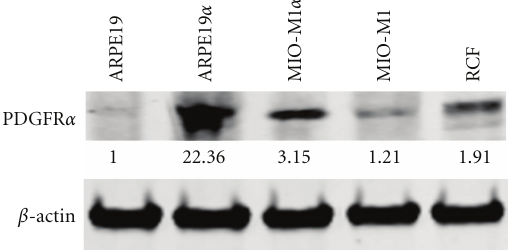
Figure 3: Western blot of ARPE19, ARPE19 α , MIO-M1 MPCs, MIO-M1 α -transfected MPCs, and rabbit conjunctival fibroblast (RCF) lysates shows comparable expression of PDGFR α in trans- fected MPCs (MIO-M1 α ) and RCFs, with levels comparable to those developed in cocultured cells. MIO-M1 α MPCs have an approximate 2.56X increase in PGFR α expression when compared to untransfected MIO-M1 MPCs, and a 1.65X increase in expres- sion when compared to RCFs. Relative expression ratios are